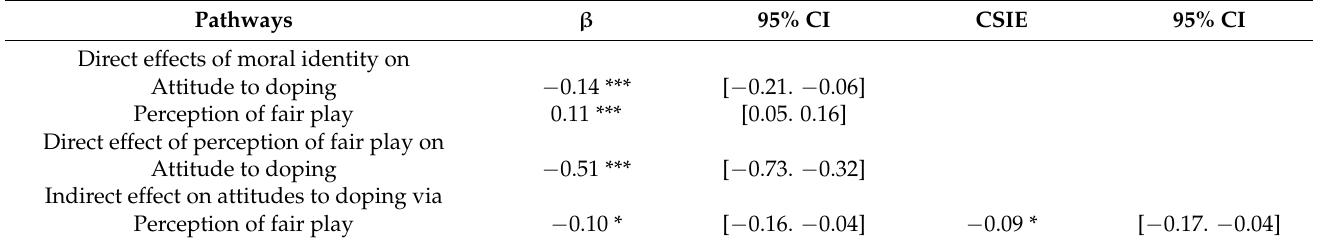
Table 2. Direct and indirect effects of moral identity on attitudes to doping among athletes.